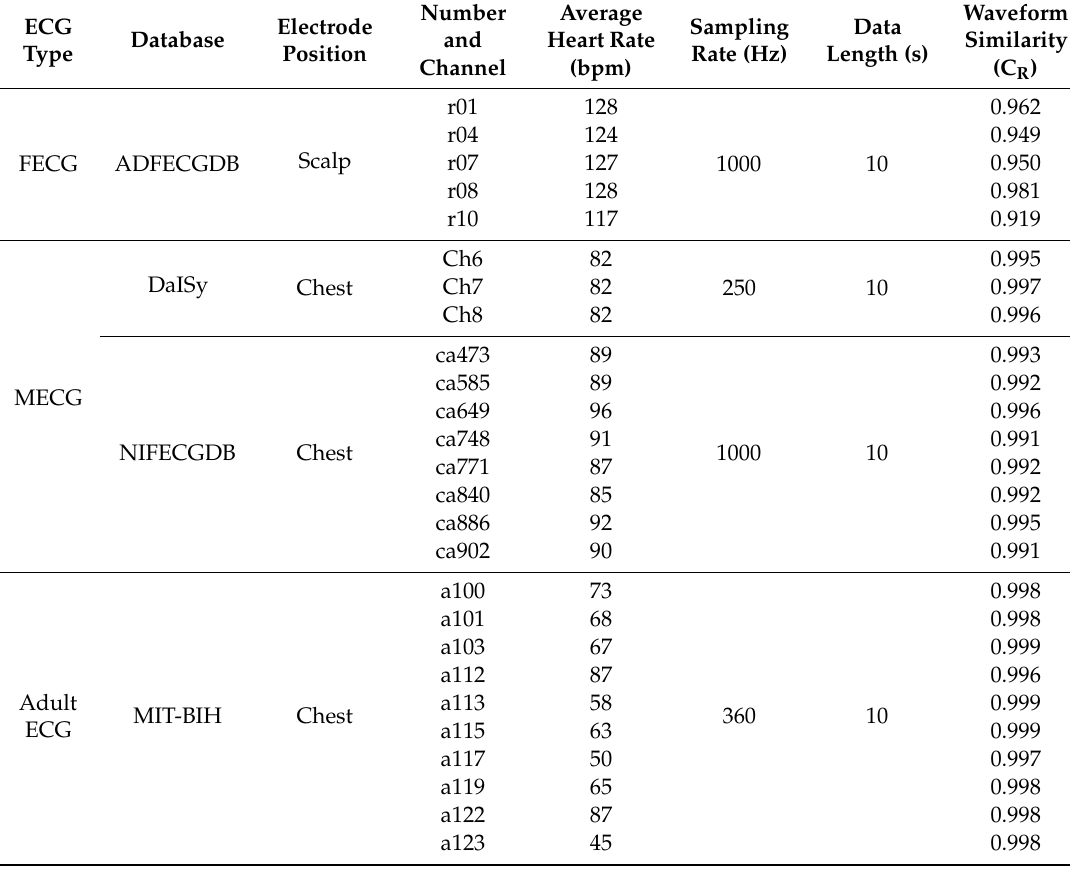
Table 1. FECGs and MECGs used for synthesising signals.